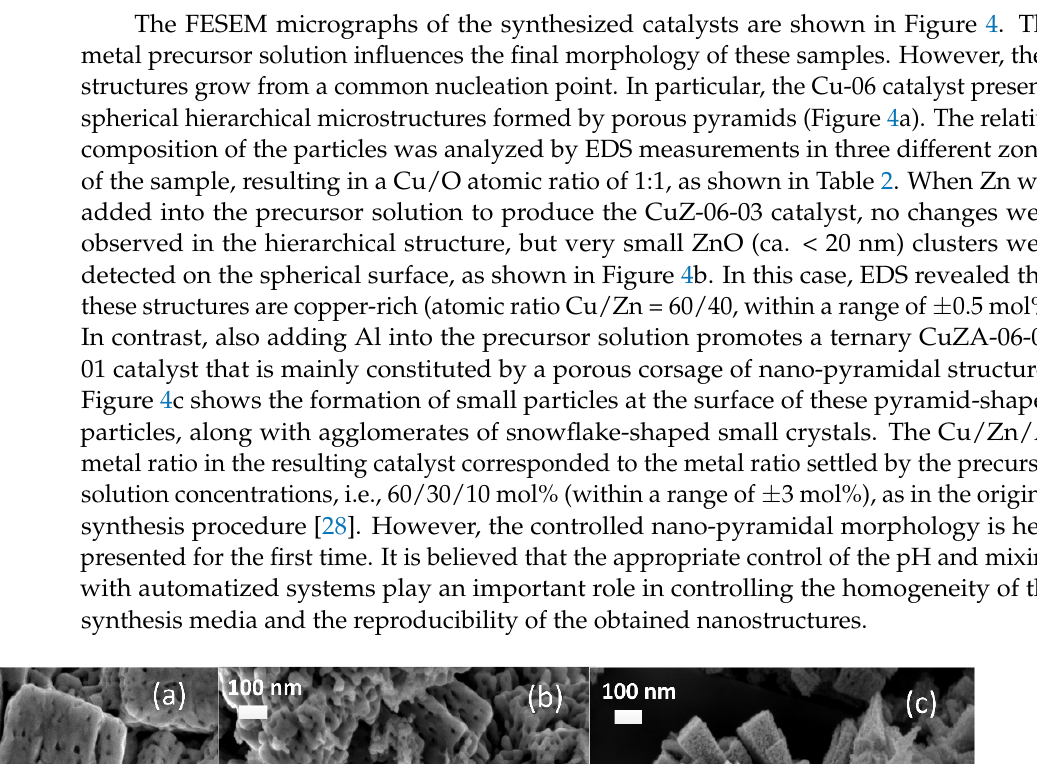
Table 2. Main textural parameters of the synthesized CuZnAl-oxide based catalysts.